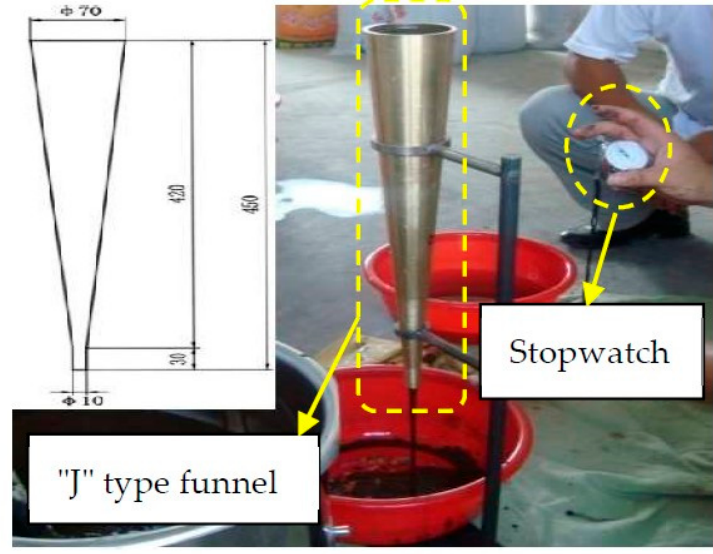
Figure 3. Testing device of the fluidity of CAM I.